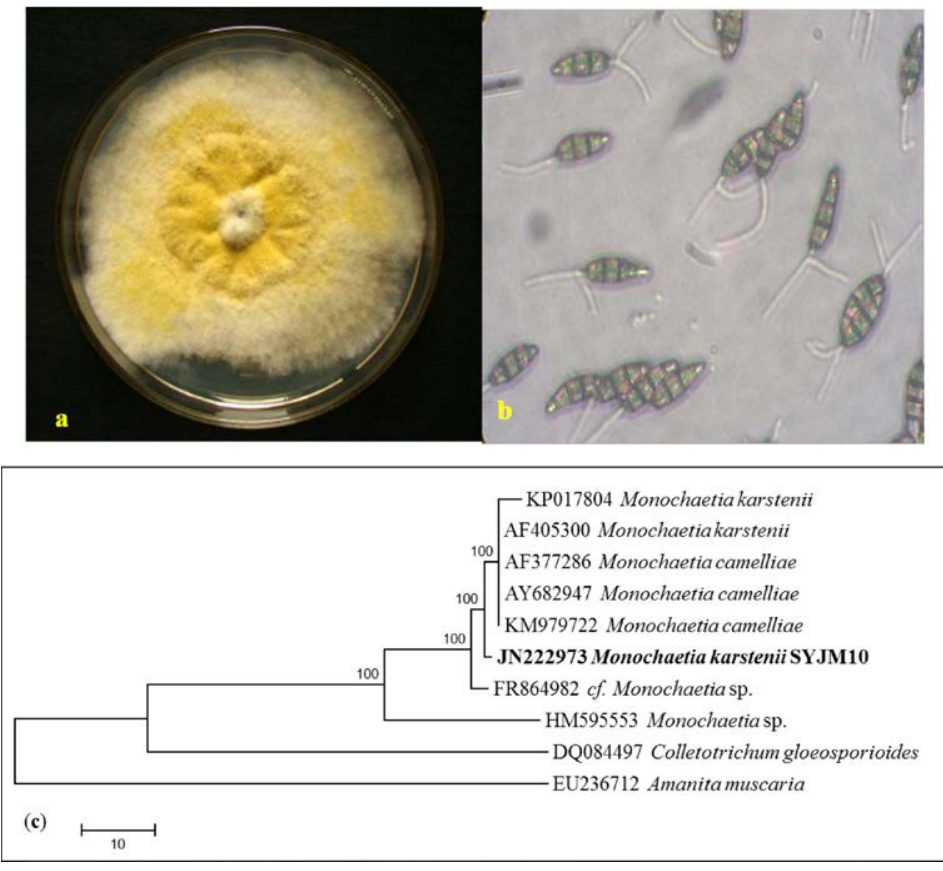
Fig. 1. (a) Culture plate showing growth of M . karstenii on MTA medium; (b) Spore morphology showing mature conidia of M . karstenii in 40 X; (c) Phylogenetic relationship of M . karstenii by Maximum parsimony